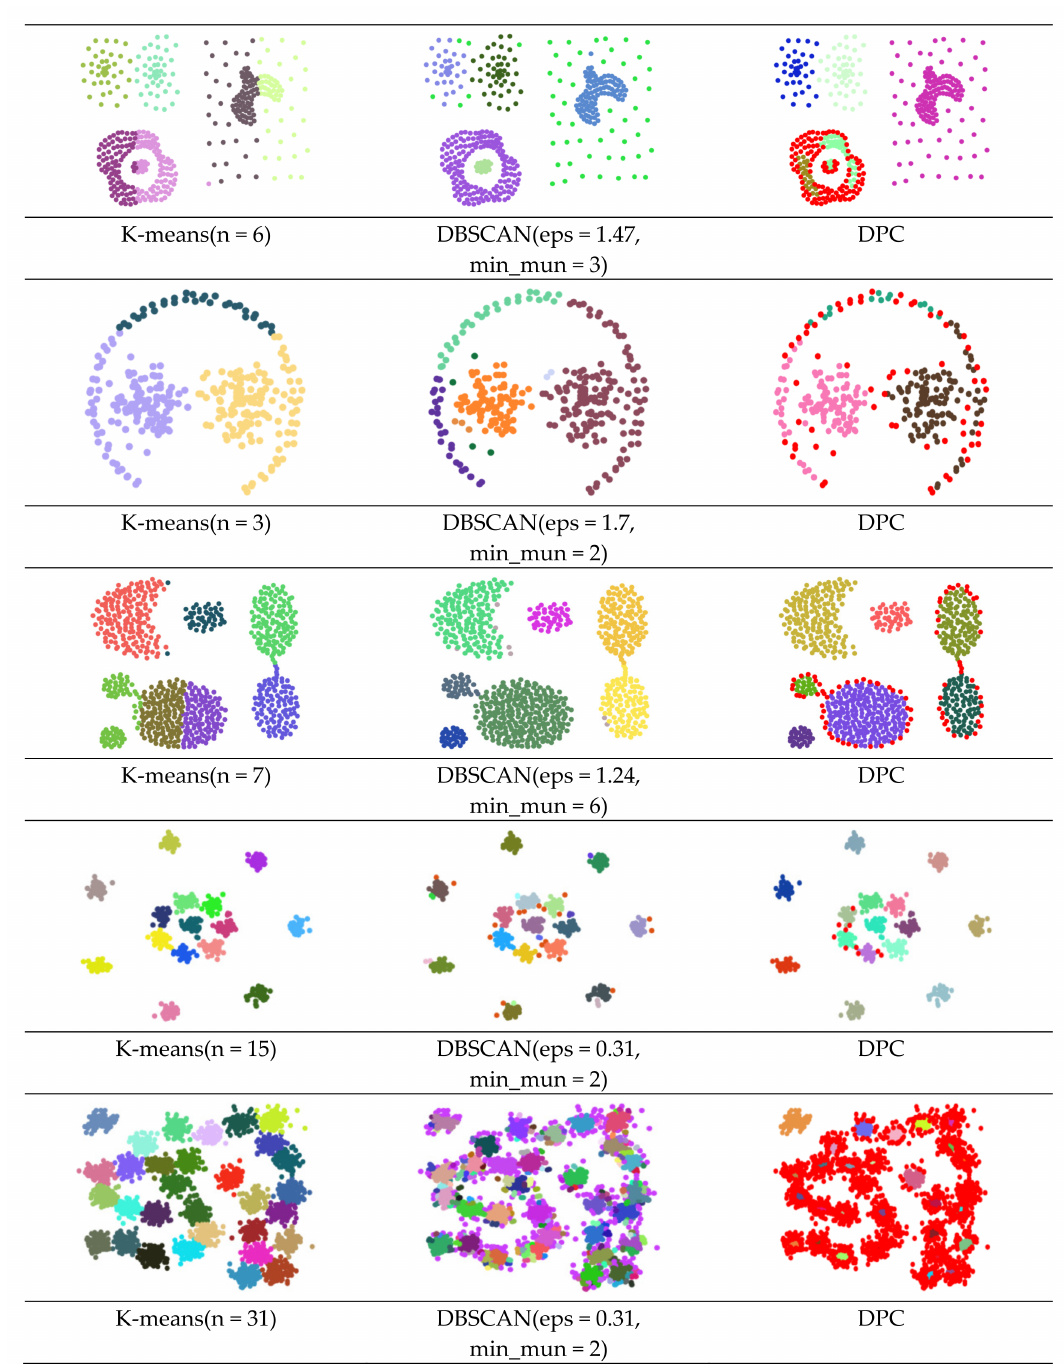
Figure 13. Clustering results by K-means, DBSCAN, and DPC of dataset